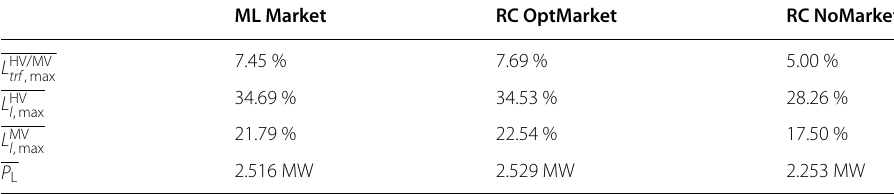
Table 1 Mean maximum values of line and trafo loadings as well as total active power